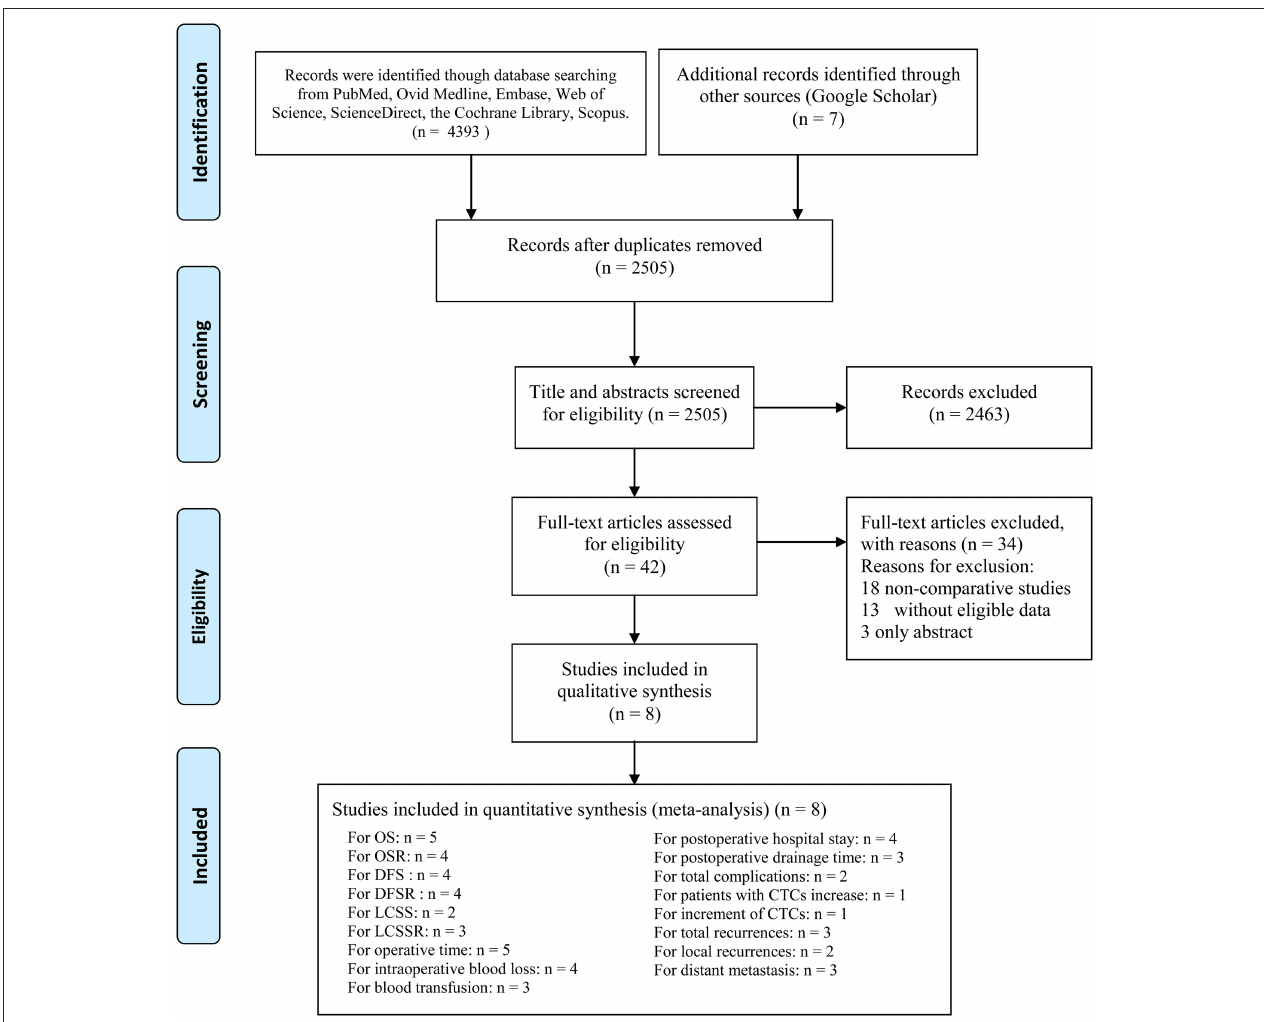
FIGURE 1 | Flow chart of the study selection